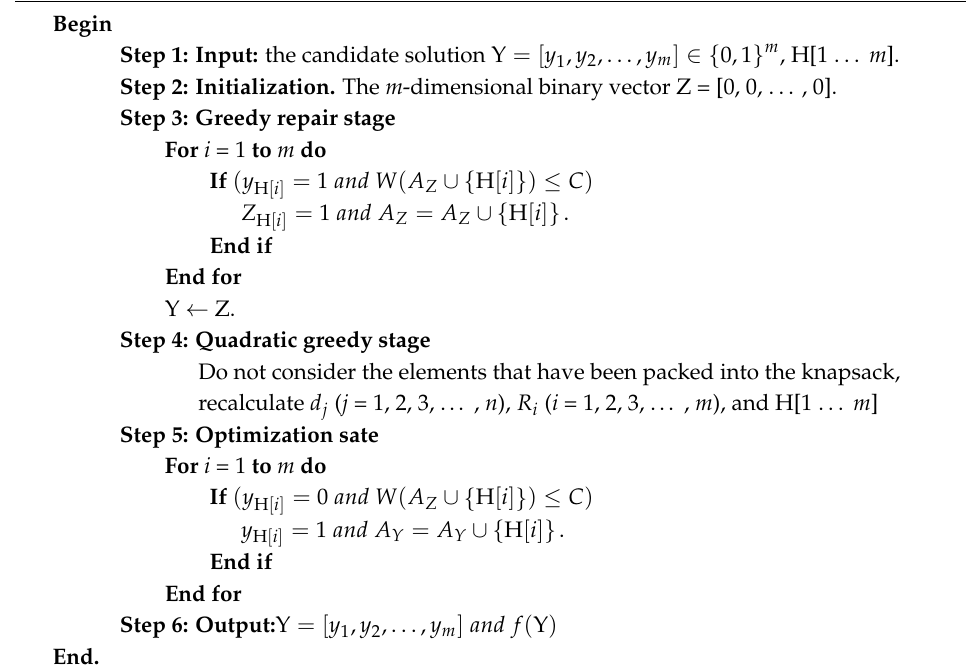
Algorithm 1. QGROS algorithm for